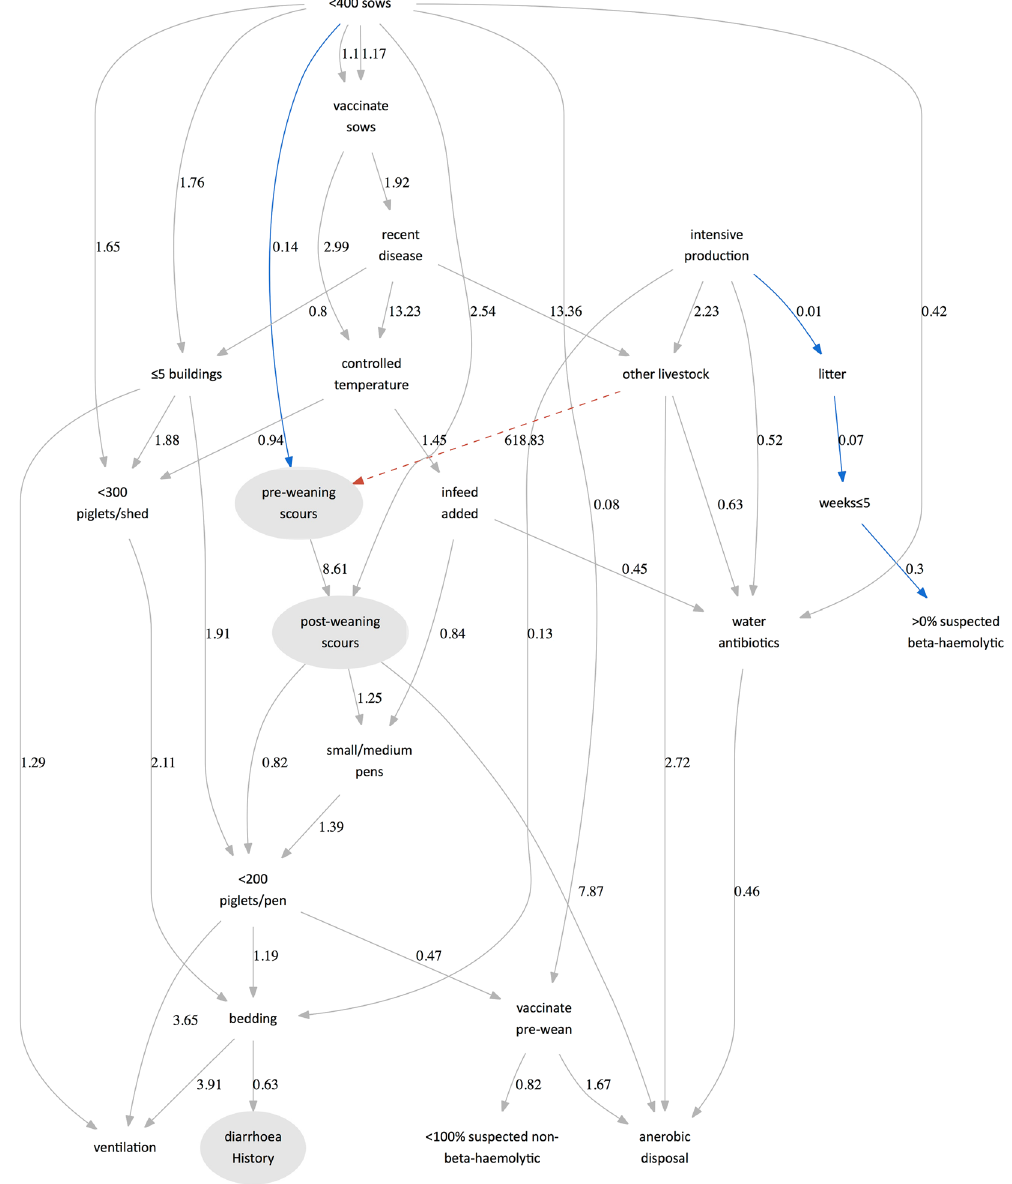
Figure 2. Additive Bayesian Network showing odds ratios of observing each a given value of a node conditional on the network. The three diarrhoeal variables are highlighted in grey. In this figure, the network includes both fixed effects and random effects for each farm. The model structure was identified via non-parametric bootstrapping and a tabu modified greedy hill-climbing search for the optimal structure. Red arcs indicate positive associations that do not include 0 in the 95% credibility interval; blue arcs are negative associations that no not include 0 in the 95% credibility interval; the 95% credibility interval of grey arcs include 0. The arc between ownership of other livestock and pre-weaning scours was manually removed because of separation in the data (at the farm level) (dashed